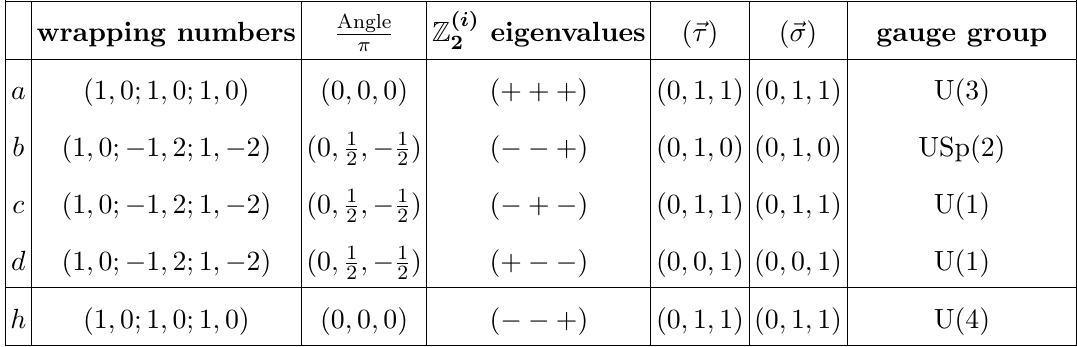
Table 16 . D6-brane con(cid:12)guration of a global (cid:12)ve-stack model with gauge group SU(3) a (cid:2) SU(2) b (cid:2) U(1) Y (cid:2) SU(4) h (cid:2) Z 3 after Green-Schwarz mechanism, which leads to the orientifold-even and -odd wrapping numbers labelled by MSSM in table